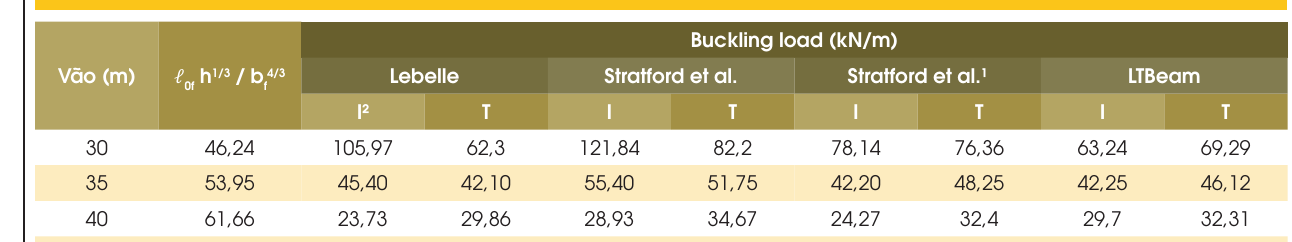
Table 8 – Buckling load of I-section beam for span variation